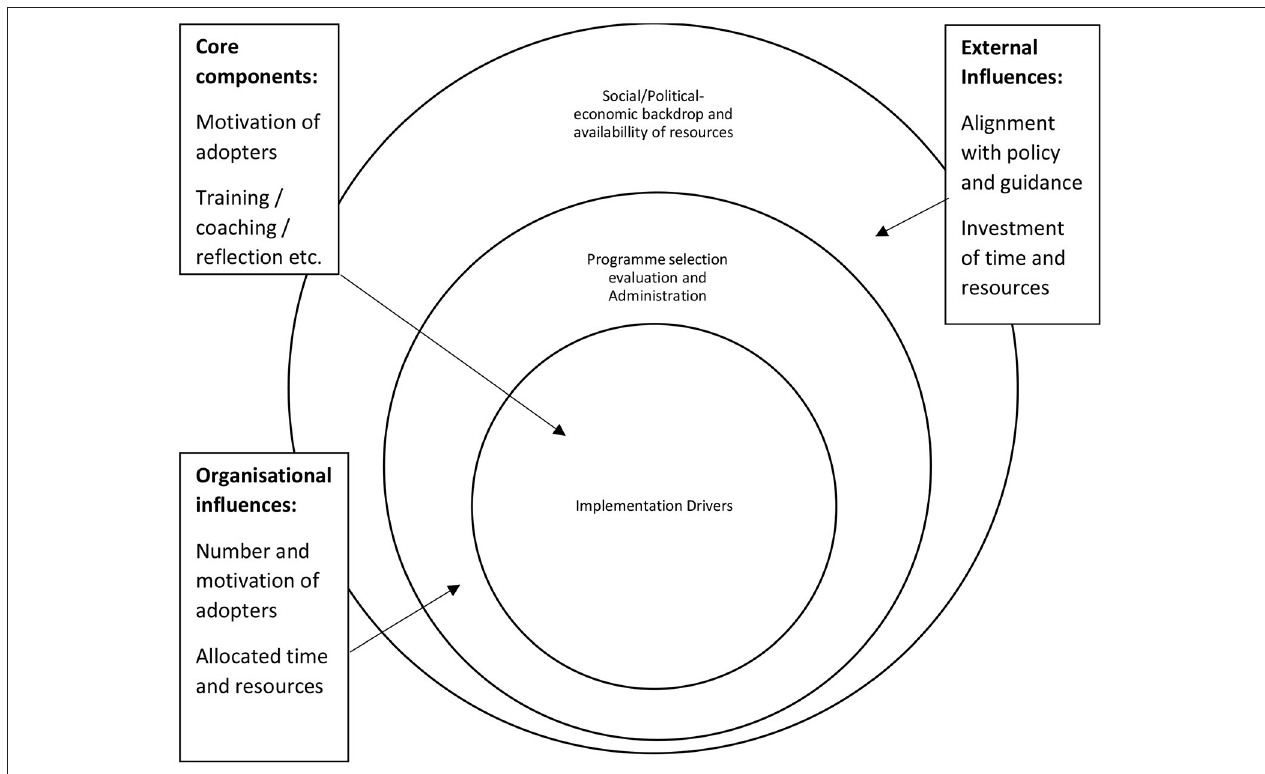
FIGURE 1 | Conceptual model of the ecology of